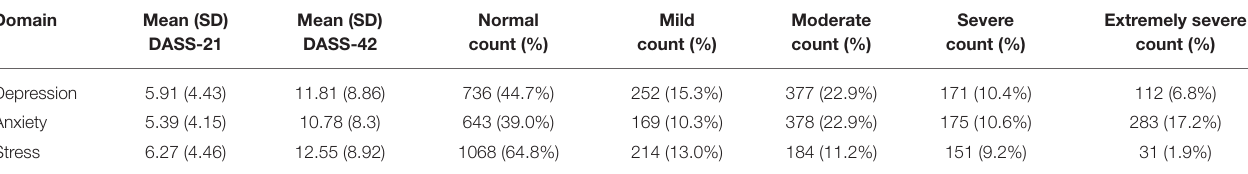
TABLE 2 | Severity distribution of depression, anxiety, stress ( N = 1,648). Domain Mean (SD) Mean (SD) DASS-21